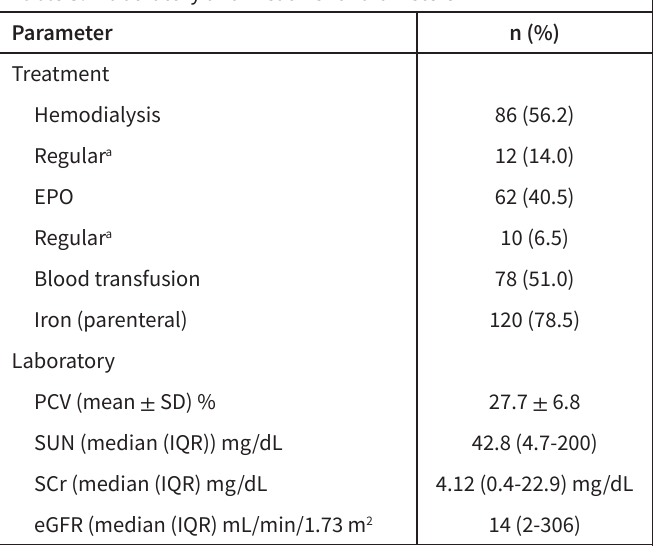
Table 3. Laboratory and Treatment